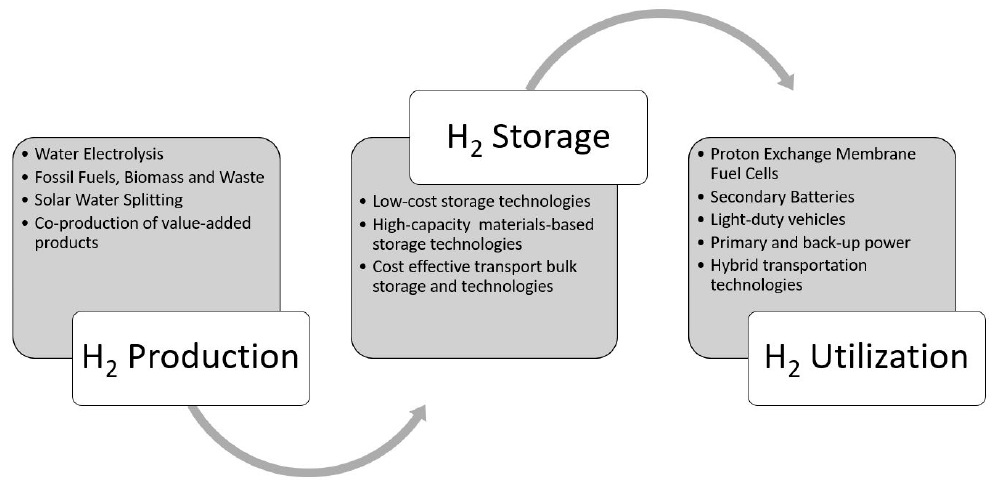
Figure 1. Storing hydrogen in the molecular or atomic form is a challenging task and equally important like producing it from clean sources and utilizing for stationary and vehicular applications (reproduced with permission from [18], Cambridge University Press, 2008).